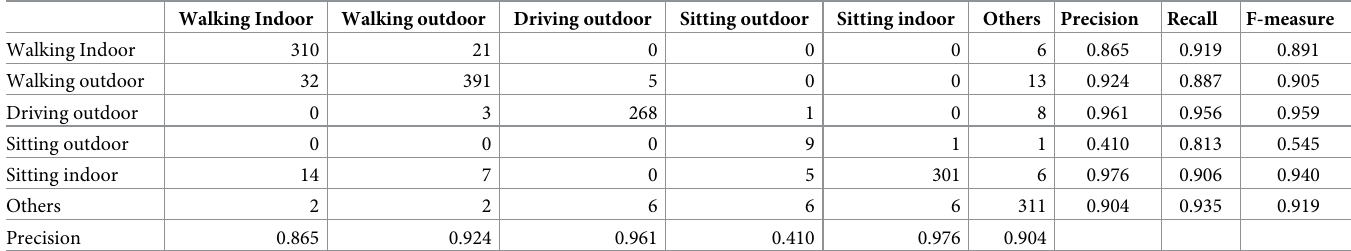
Table 5. Evaluation results for 10% of manually annotated data which were not taken into consideration during the training procedure. Walking